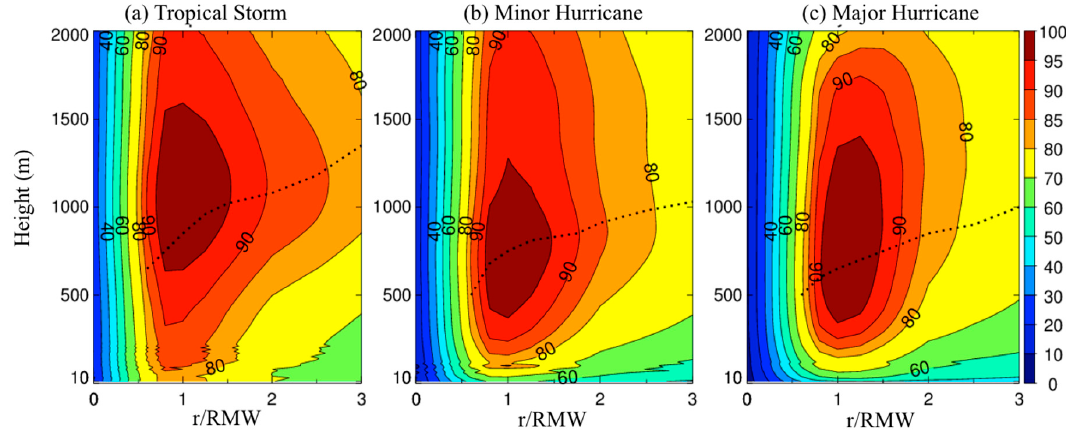
Figure 4. Composite analysis of the tangential velocity, as a function of altitude and the normalized radius, normalized by the composite-peak values for ( a ) tropical storms, ( b ) minor hurricanes, and ( c ) major hurricanes.